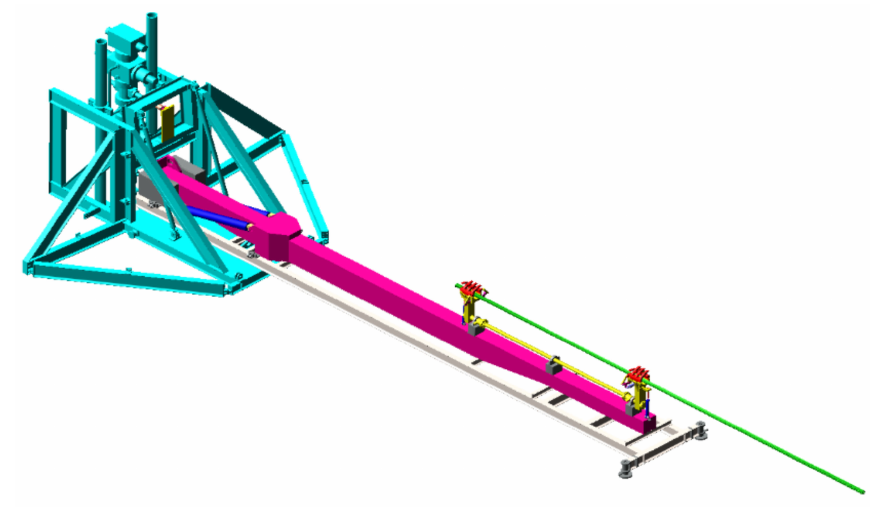
Figure 7. The rigid–flexible coupling dynamic model in